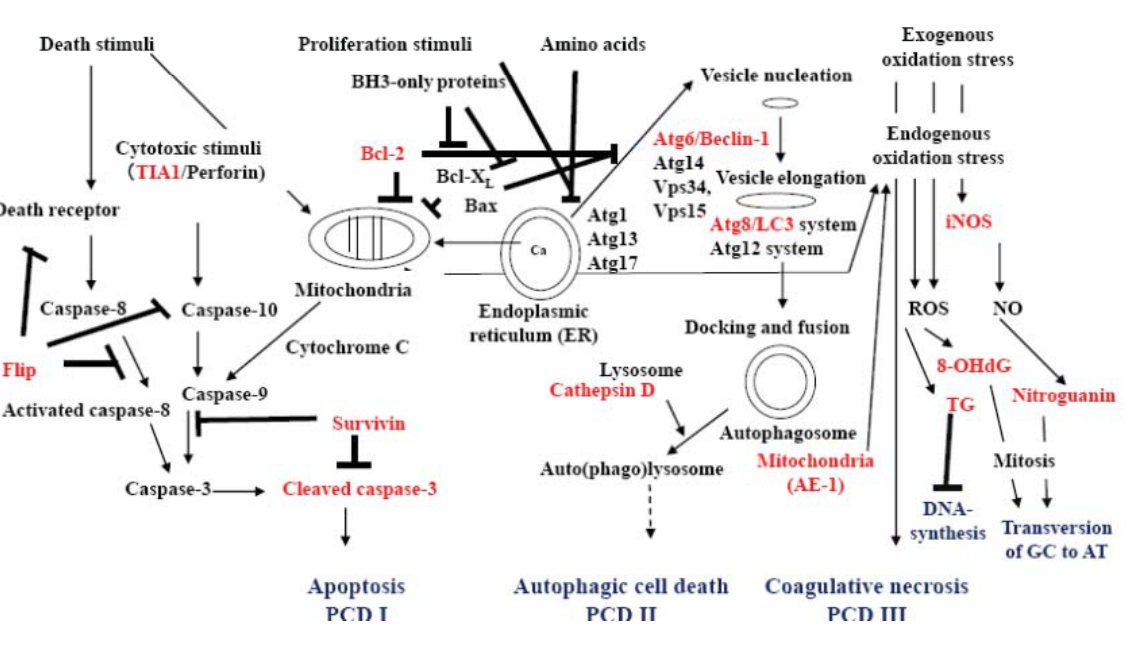
Figure 3. Conceptual graphic understanding of signal transduction in apoptosis, autophagy, oxidative stress and programmed cell death. Death signals from cell membrane receptors, receptor caspase-10 and from the mitochondria result in the formation of cleaved caspase-3, which initiates the signaling processes of apoptosis (PCD I). However, there are several antagonists of apoptosis, such as Flip against caspase-8, Bcl-2, Bcl-XL and Bax for mitochondria membrane stability, and survivin that is an inhibitor of apoptosis-1 (IAP-1) for cleaved caspase-3. Survivin is expressed in stem cells, fetal tissue, cancer cells and lymphoma cells. Proliferation signals and starvation (amino acid) through mTOR initiate complex formation of Atg1, Atg13 and Atg17 at the endoplasmic reticulum. Stabilization of ATG6/beclin-1 by Bcl-2, Bcl-XL and Bax is lost. Beclin-1 then forms an autophagic vesicle nucleation complex with Atg14, Vps34, and Vps15 and enhances autophagy. The Atg8/LC3 and Atg12 systems elongate autophagic vesicle to engulf a part of the cytoplasm with organelles such as mitochondria and create autophagosomes. Membrane-boundary form LC3 (LC3-II) localizes within the autophagic vesicle’s double membrane. Autophagosome fuses with a lysosome to form an auto(phago)lysosome, and the engulfed content is digested by lysosomal enzymes such as cathepsin D. Autophagy results in the recruitment of amino acids or cell survival. Over-enhanced autophagy and mal-digestion in the autolysosome lead to accumulation of autolysosomes in the cytoplasm and the cell undergoes autophagic cell death (PCD II). Strong death stimuli and exogenous and endogenous stress induce mitochondria to produce hydroperoxyl radical and metal hydroperoxo complexes, which oxidize the cytoplasm strongly and induces coagulative necrosis, possibly PCD III, and produce reactive oxygen species (ROS). In auto(phago)lysosome, mal-digested mitochondria yield endogenous ROS. Exogenous and endogenous ROS oxidizes DNA to yield 8-hydroxydeoxyguanosine (8-OHdG) and thymidine glycol (TG). However, strong stress causes the cell to express inducible nitric oxide synthase (iNOS), which generates nitric oxide (NO) and nitrates DNA to yield nitroguanosine (NG). Accumulated TG disturbs DNA synthesis. 8-OHdG and NG possibly induce GC to AT transversion in DNA when most of the 8-OHdG is removed from the repaired DNA into urine. A small amount of NO induces heam oxygenase as a signal molecule to produce an anti-oxidation